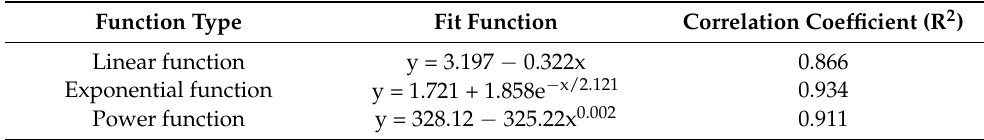
Figure 19. Relationship between the total porosity and the tensile strength. Table 5. Fitting results of the relationship between total porosity and tensile